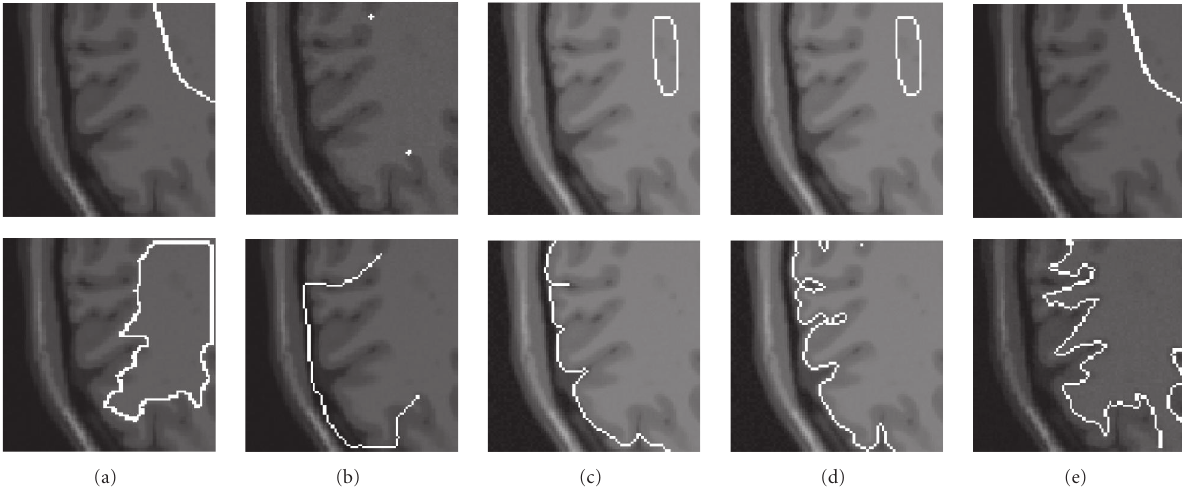
Figure 4: Comparison of di ff erent segmentation results for the white matter and gray matter boundaries using di ff erent active contour models. The gradient information used in panels (a), (b), and (e) is shown in Figure 3. The top row shows the original image and initializa- tions. The bottom row shows the corresponding segmentation results. (a) Geodesic active contours su ff er from undesirable local minima; (b) the minimal path technique relies on the location of initial points and strong gradient information; (c) and (d) Chan-Vese method and Mumford-Shah method find more global minima over the whole image. (e) Improved edge extraction using dual-front active contours with the same initialization used for geodesic active